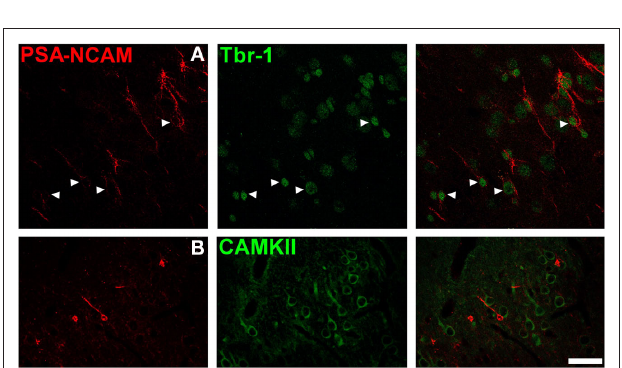
Figure 3 | immature phenotype of PSA-NCAM expressing neurons in the cat cerebral cortex layer ii. PSA-NCAM expressing cells in layer II (asterisks) co-express the immature neuronal markers doublecortin (DCX) (A) and the cyclic nucleotide-gated cation channel 3 (CNGA3) (B) . Some PSA-NCAM